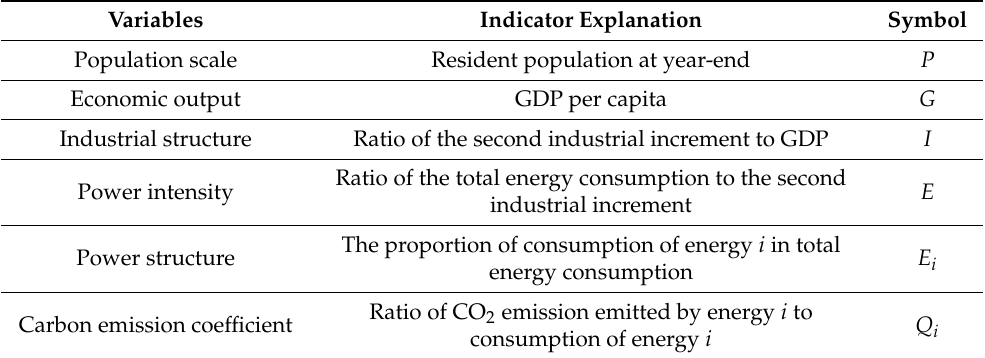
Table 3. Variables influencing